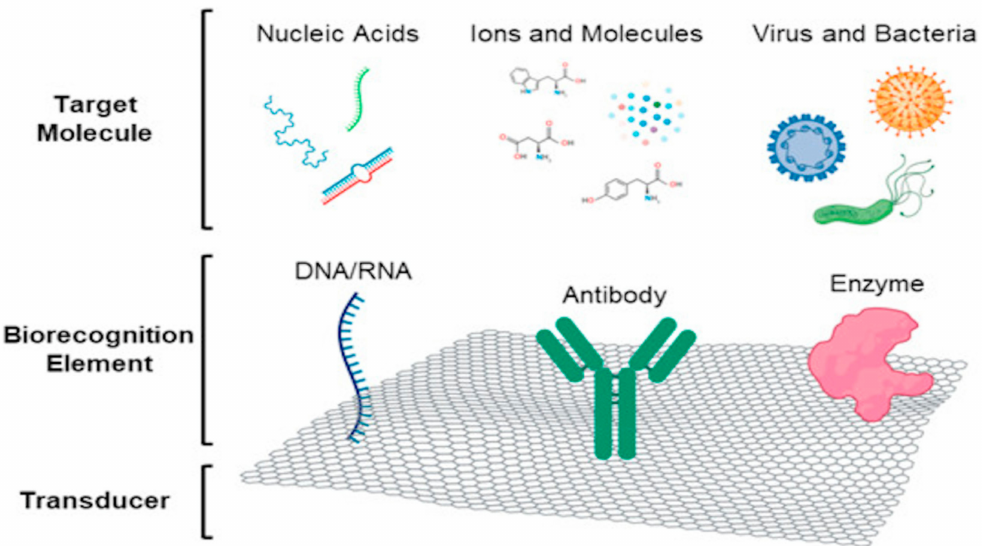
Figure 2. A typical saliva-based biosensor. Briefly, it consists principally of three components, a surface (carbon-based or metal) to accommodate the biorecognition element (probes, antibodies, or enzymes), which captures the target (genomic material, antibodies, proteins, etc.). The molec- ular interactions induce colorimetric or spectrometric changes, which can be observed with their corresponding detection technologies. Image used with permission from Goldoni et al., 2021